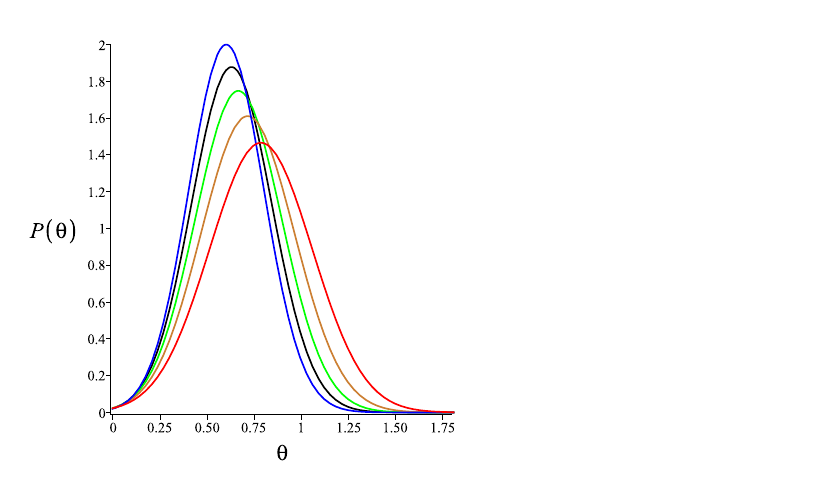
Figure 4. The probability density of the orientation of the tip of a single grafted filament with a magnetic bead, as shown by Equation (8). The red, gold, green, black and blue colours correspond to K B = 0, K B = 3, K B = 6, K B = 9 and K B = 12, respectively. The fixed parameters for all curves are: L = 1 µ m; l p = 27 µ m; ω = π ; θ B = π ; and θ µ = 8 4